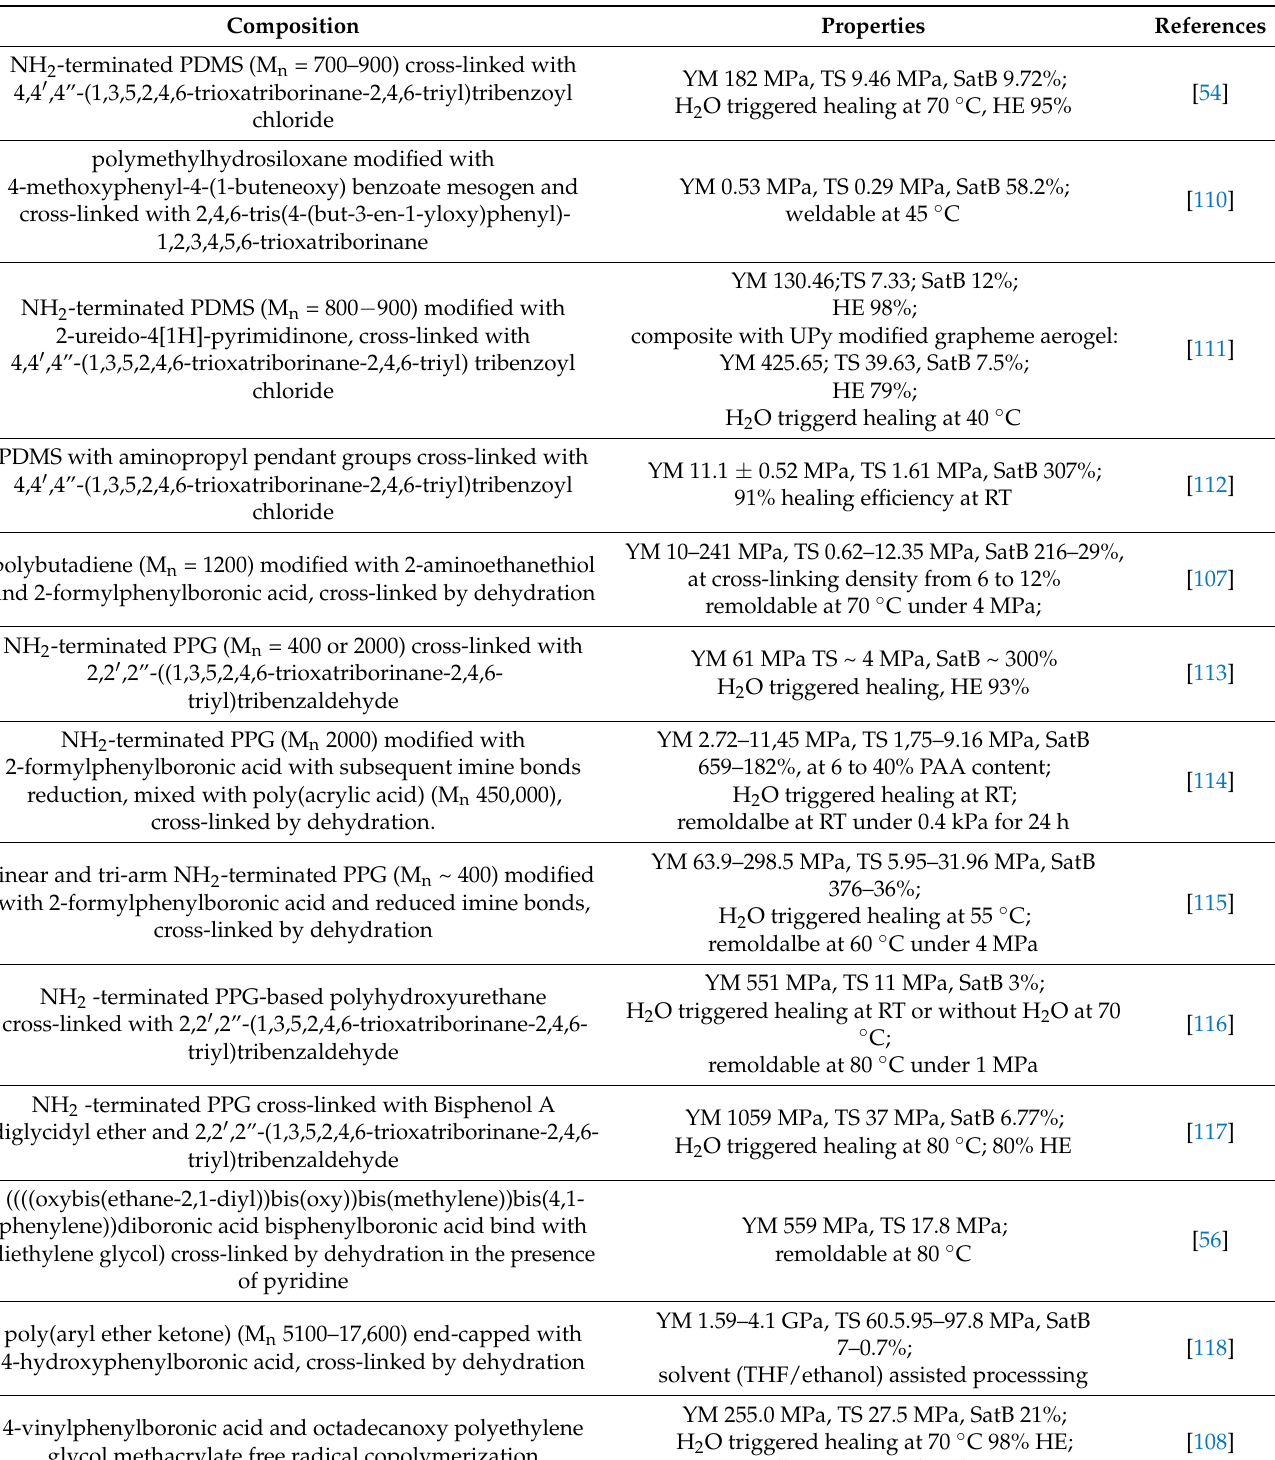
Table 3. An overview of dynamic networks based on boroxine